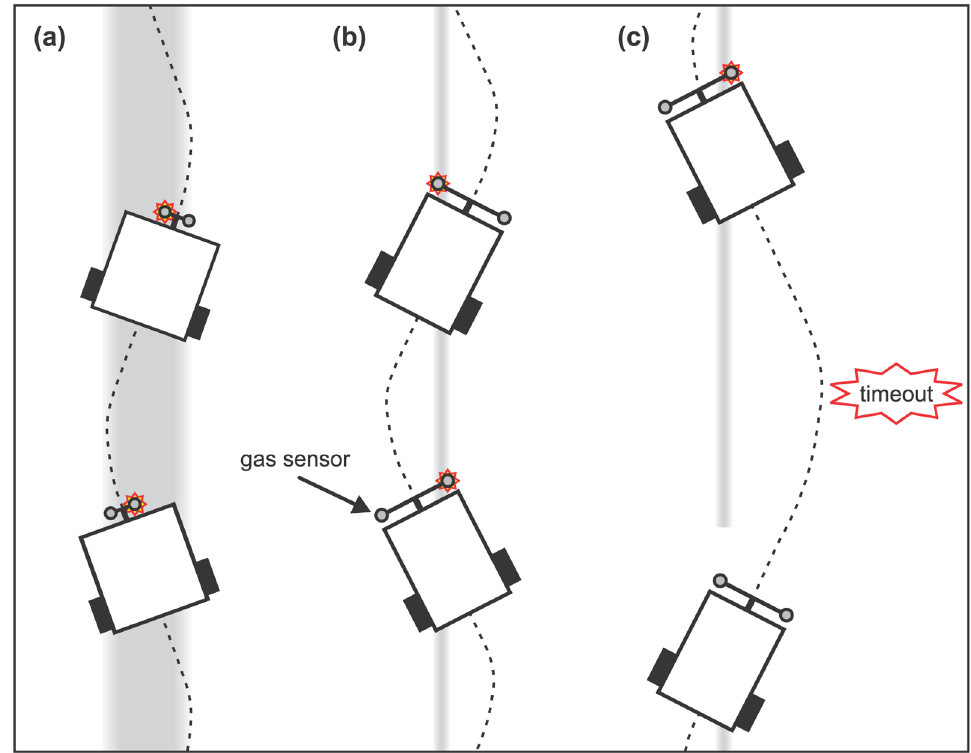
Figure 9 . Trail following strategies with a pair of sensors. (a) Chemo-tropotaxis to keep a pair of sensors over the trail. (b) Chemo-tropotaxis to keep the trail between the pair of sensors. (c) Timeout mechanism to increase robustness against measurement errors or intermittent trails. The idealised trail is indicated by a bright grey vertical stripe. A star around a sensor indicates that this sensor detects the trail.